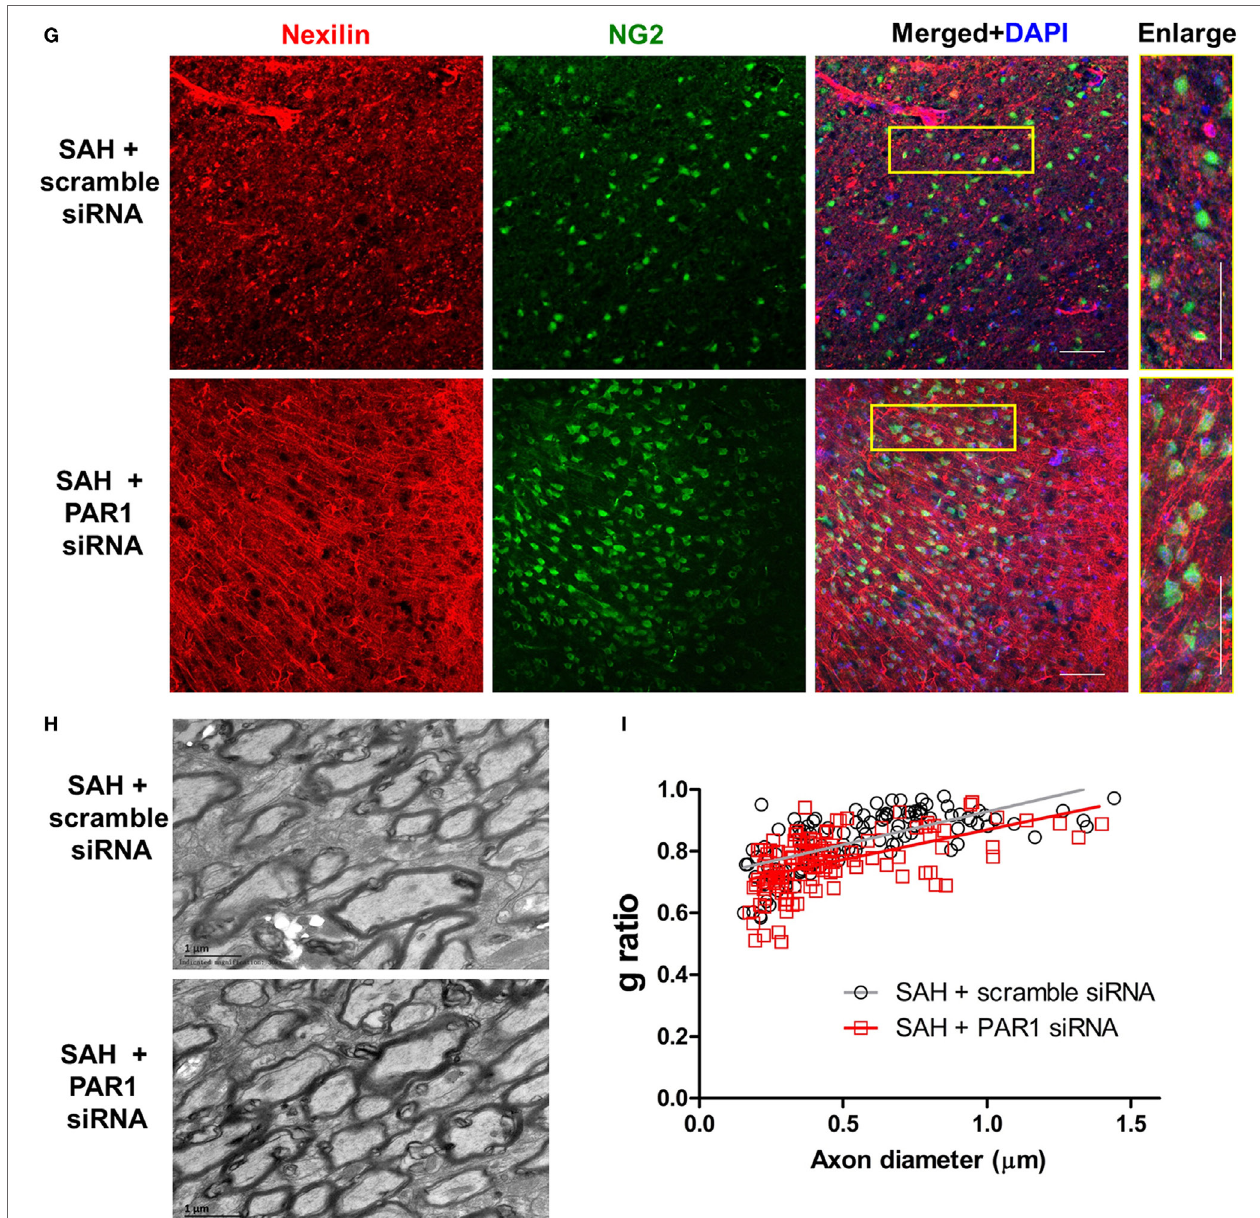
FigUre 6 | Inhibition of protease-activated receptor 1 (PAR1) enhanced nexilin expression and facilitated remyelination after subarachnoid hemorrhage (SAH). (a) Western blot analysis of PAR1, Ras-proximate-1 (RAP1), phosphorylated RAP1 (pRAP1), nexilin, and GAPDH in white matter at 3 days after SAH. (B–F) Respective statistical histograms of normalized expressions of PAR1, RAP1, pRAP1, nexilin, and pRAP1/RAP1 ratio, n = 6 for each group. # P < 0.05 versus SAH + scramble siRNA group, ## P < 0.01 versus SAH + scramble siRNA group, ### P < 0.001 versus SAH + scramble siRNA group. (g) Representative images of NG2 and nexilin expression (20 × ) at 3 days after SAH are shown. Scale bar = 50 µm. (h) Representative transmission electron microscopy images of myelin in the SAH + scramble siRNA and SAH + PAR1 siRNA groups. (i) Respective g -ratios of the SAH + scramble siRNA ( y = 0.2142 x − 3.333, r 2 = 0.4398) and SAH + PAR1 siRNA groups ( y = 0.1943 x − 3.473, r 2 =